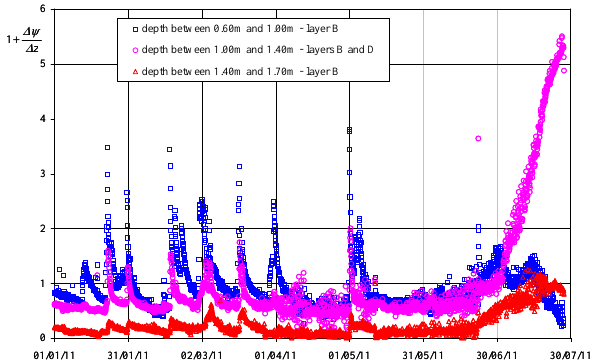
Fig. 3. Soil water potential vertical gradients estimated from field